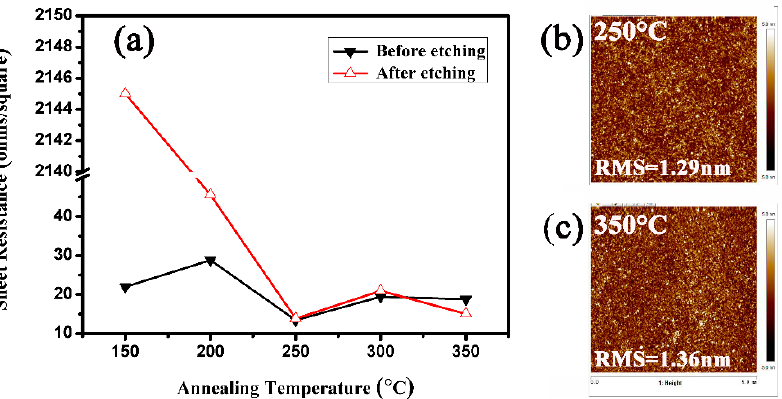
Figure 1. Sheet resistance of Ni/Ti/Ge samples annealed at various temperatures. ( a ) AFM surface morphologies with the scanning area of 5 × 5 µm 2 of ( b ) 250 °C, ( c ) 350 °C annealed sample.